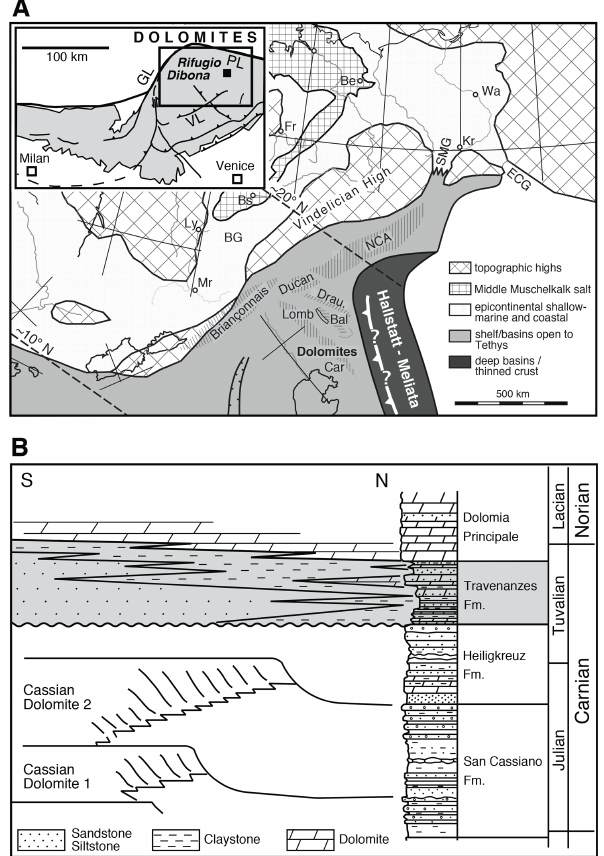
Figure 1. (a) Palaeogeographic map of southern Alpine to Ger- manic domains during the middle Triassic; reproduced from Brack et al. (1999; modified). Bal: Balaton; BG: Burgundy Gate; Car: Car- nian Alps; ECG: eastern Carpathian Gate; Lomb: Lombardy; NCA: Northern Calcareous Alps; SMG: Silesian Moravian Gate. The fol- lowing cities are indicated for orientation: Mr: Marseille; Wa: War- saw; Kr: Kraków; Be: Berlin; Fr: Frankfurt; Ly: Lyon. Inset: tec- tonic map of the southern Alps (Brack et al., 1996; modified) show- ing the sampling location at Rifugio Dibona. GL: Giudicarie Line; PL: Pustertal Line; VL: Val Sugana Line. (b) Middle to Upper Trias- sic stratigraphy and distribution of facies within the Venetian Alps, showing a transition in geometries from a basin and platform to- pography during the lower Carnian to an extended alluvial to tidal plain in the upper Carnian. The shaded area indicates the Trave- nanzes Fm., showing a lateral transition in facies and a transgressive boundary with the Dolomia Principale. Compiled from Breda and Preto (2011), after De Zanche et al. (1993); modified.